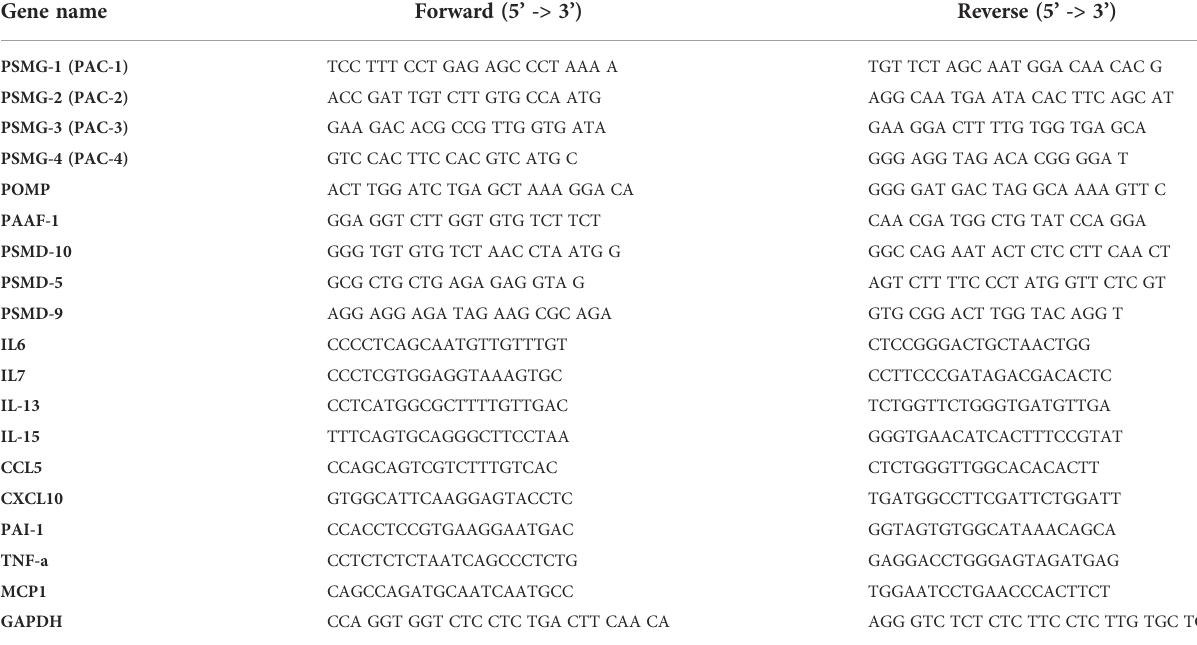
TABLE 1 Gene primer sequences for